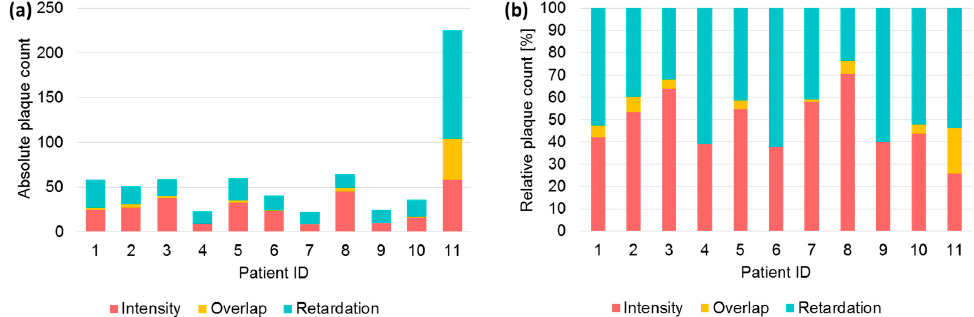
Figure 4. Overview of plaques segmented in the OCT data sets of eleven patients in 500 µ m × 500 µ m × 500 µ m fields of view (FOV). ( a ) Plaque count in retardation and intensity data including the overlapping plaques (i.e., plaques observed both in intensity and retardation images) plotted for each patient. ( b ) Relative plaque count in retardation and intensity data including the overlapping plaques plotted with age. Patients with two data sets were averaged and mean values are plotted.